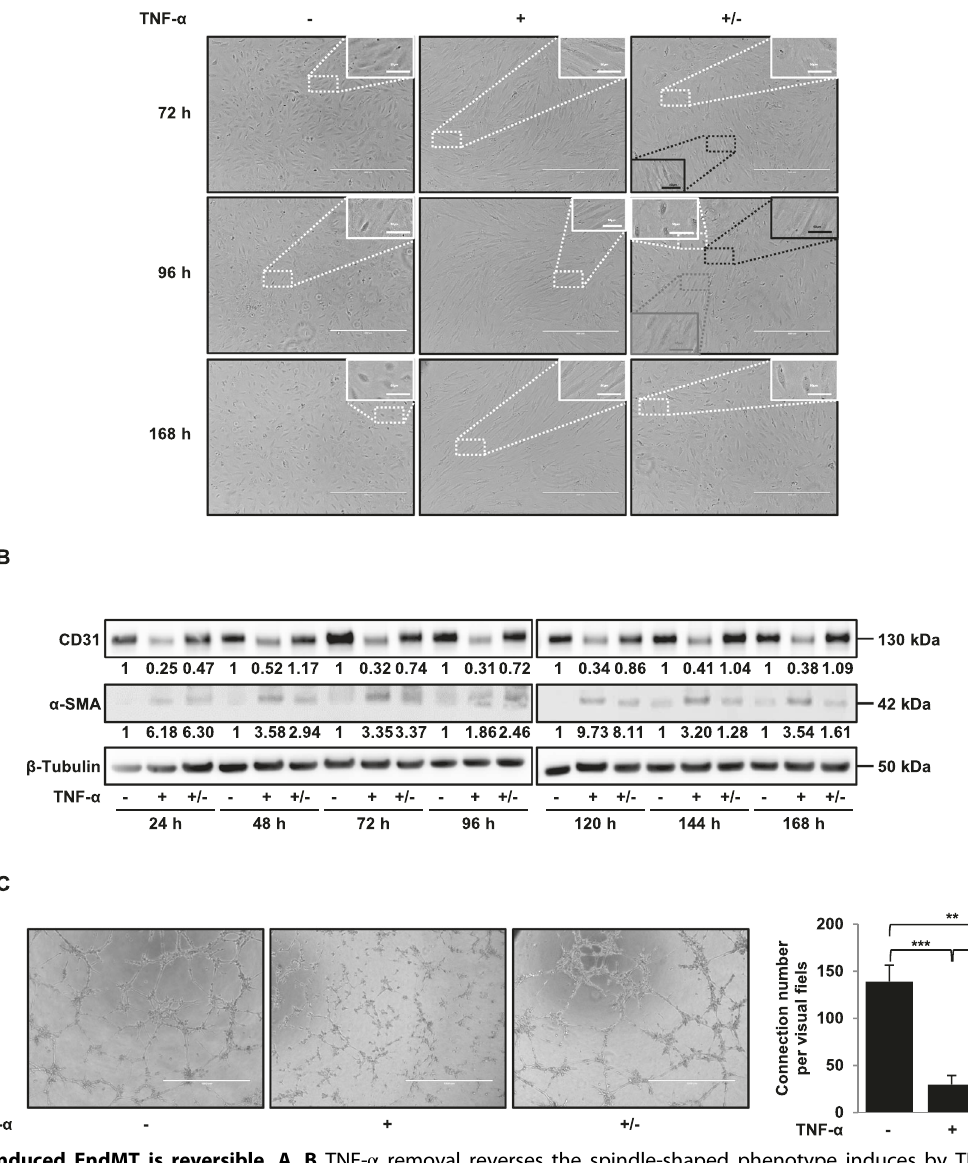
tumour necrosis factor- α , α -SMA α -smooth muscle actin, Ctrl